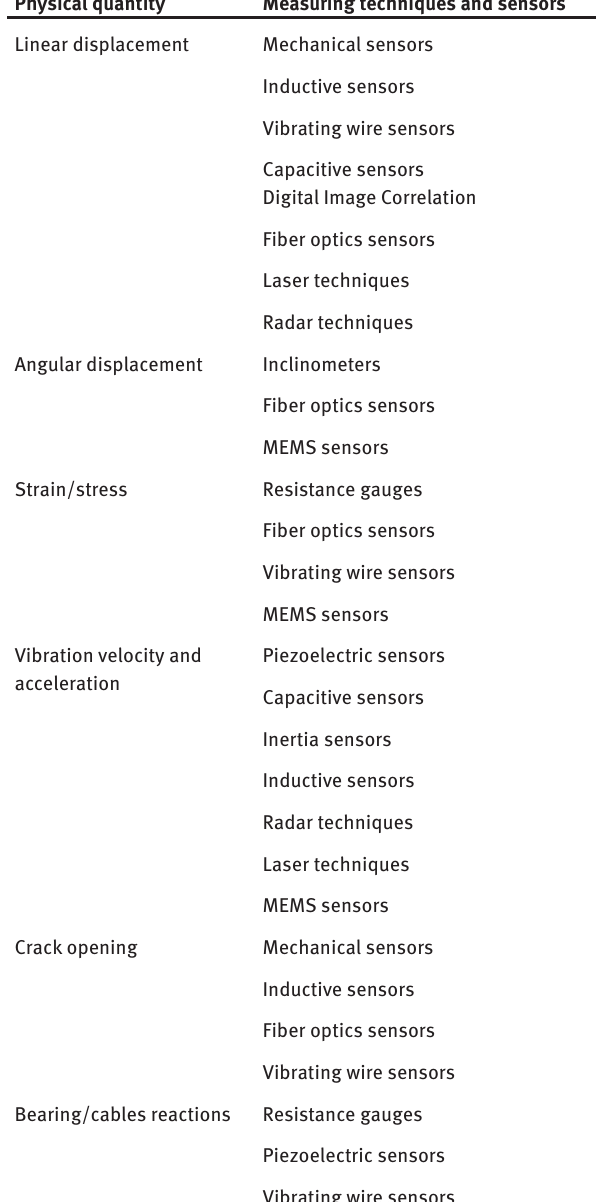
Table 1: Measuring techniques and sensors used in dynamic tests of